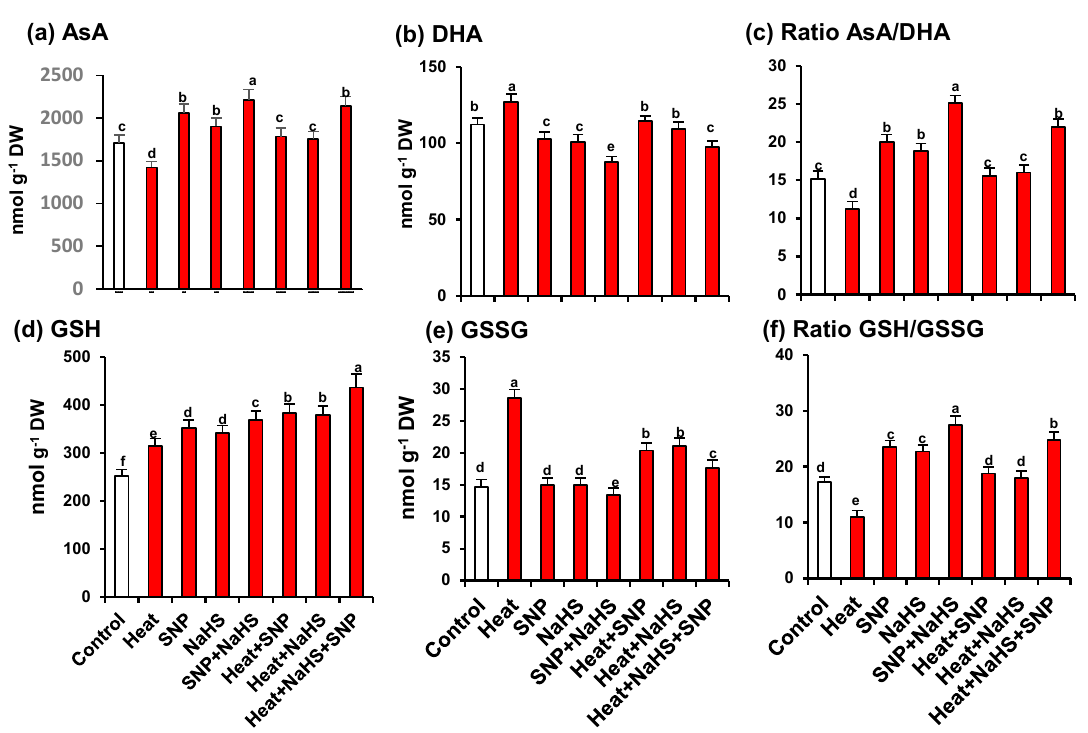
Figure 8. Content of non-enzymatic antioxidants of the ascorbate-glutathione cycle in leaves of wheat ( Triticum aestivum L. var. WH 542) plants treated with SNP (100 µ M) and/or NaHS (200 µ M) in the presence (40 ◦ C) or absence (25 ◦ C) of heat stress at 30 days after sowing (DAS). ( a ) Ascorbate (AsA). ( b ) Dehydroascorbate (DHA). ( c ) Ratio AsA/DHA. ( d ) Reduced glutathione (GSH). (e) Oxidised glutathione (GSSG). ( f ) Ratio GSH/GSSG. Data are presented as treatments mean ± SE ( n = 4). Data followed by same letter are not significantly different by LSD test at ( p < 0.05). DW, dry weight. SNP, sodium nitroprusside. NaHS, sodium